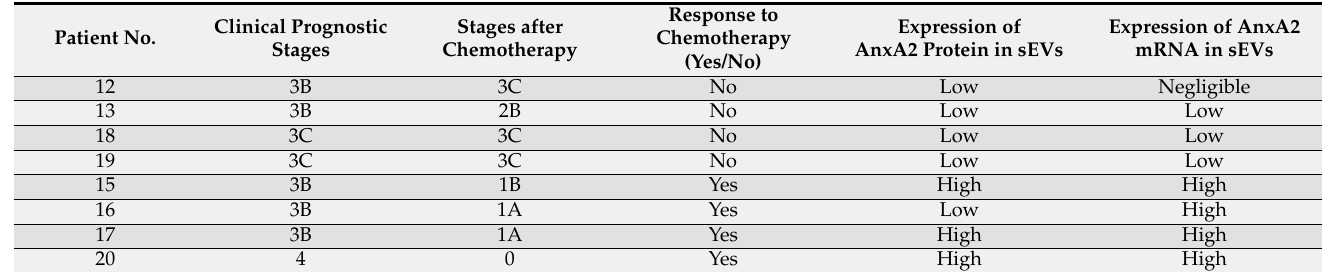
Table 1. The expression of the AnxA2 protein and mRNA derived from sEVs in the TNBC patients with stage 3 and above.